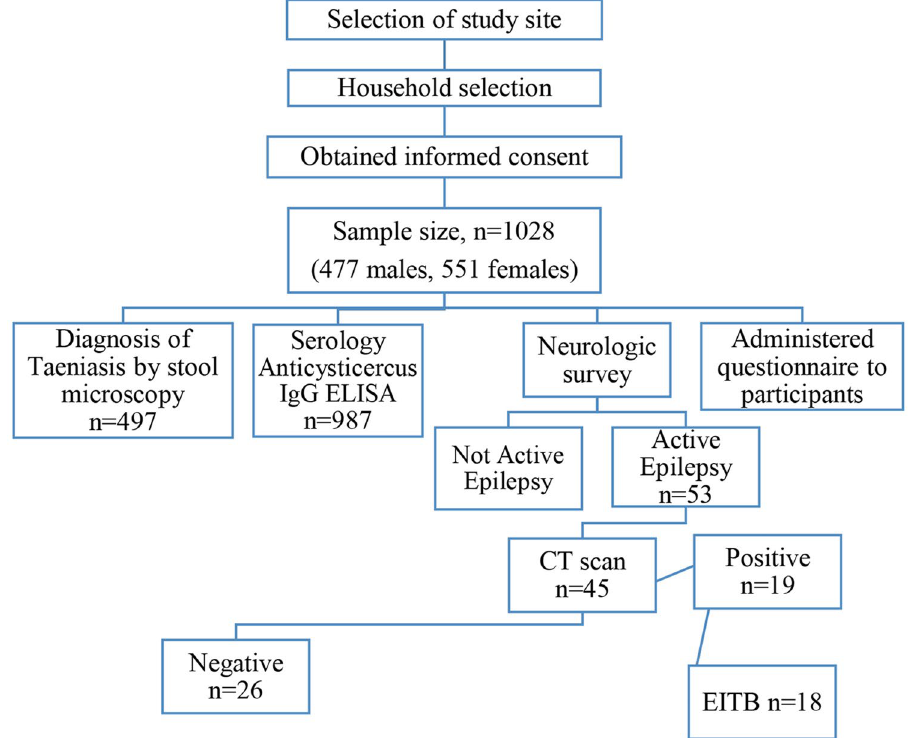
evaluations to establish the diagnosis of